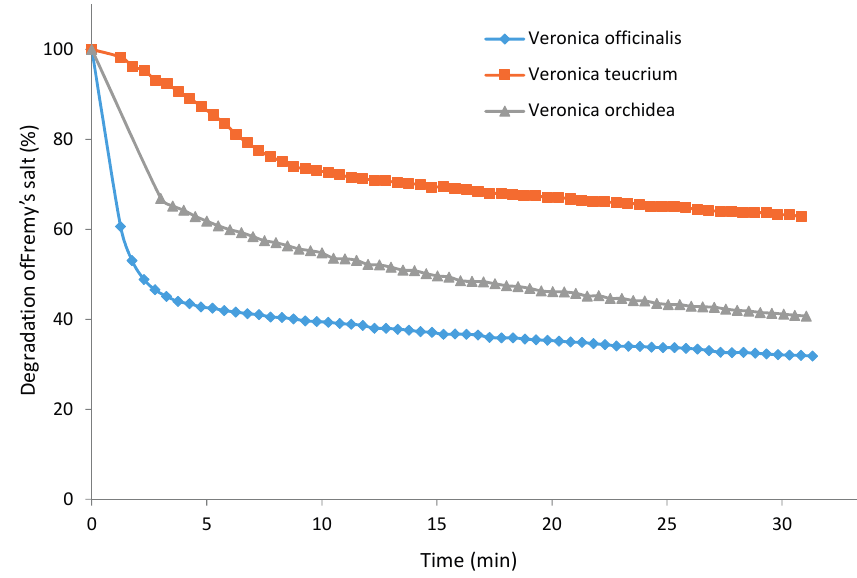
Figure 5. Degradation kinetics of the free radical Fremy’s salt by V. officinalis , V. teucrium and V. orchidea